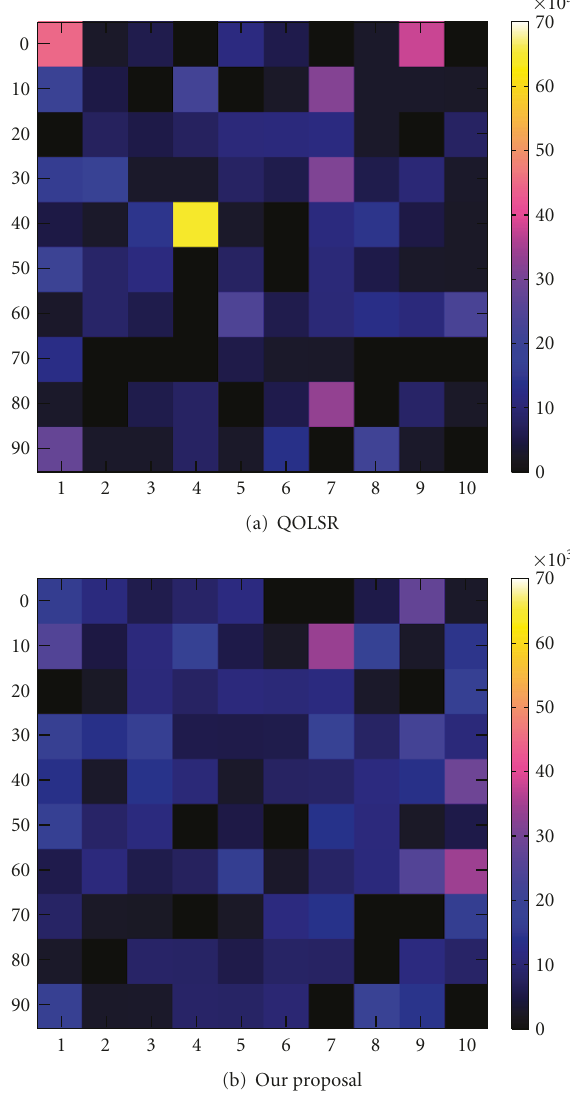
Figure 7: Comparison of total number of transmitted MAC frames.